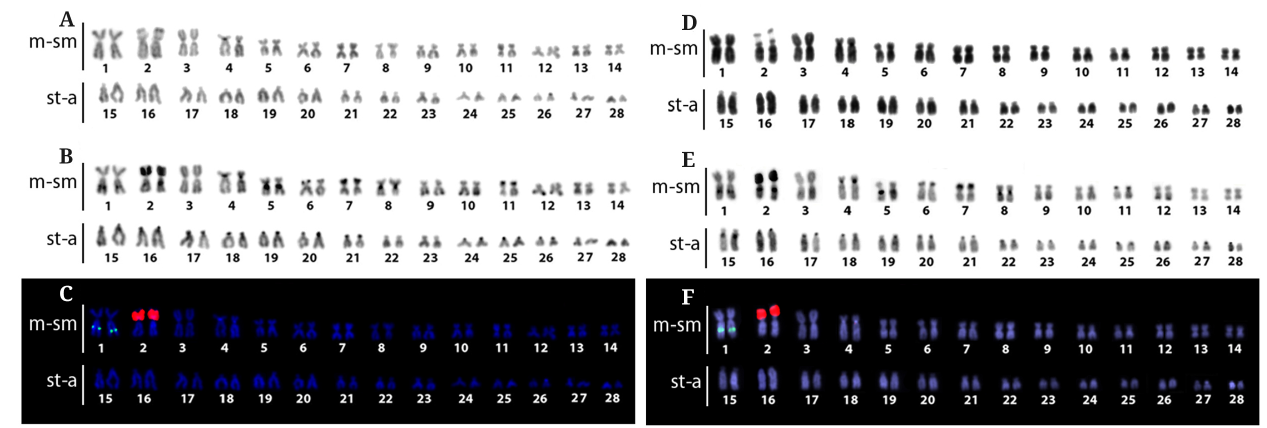
FIGURE 2 | Karyotypes of Arapaima gigas male ( A – C ) and female ( D – F ) from Javaé (JAV) population (Araguaia-Tocantins River basin), sequentially arranged from Giemsa-stained ( A and D ), C-banded ( B and E ), and double-FISH ( C and F ) with 5S rDNA (green) and 18S rDNA (red) labeled chromosomes. Bar=5 µm.